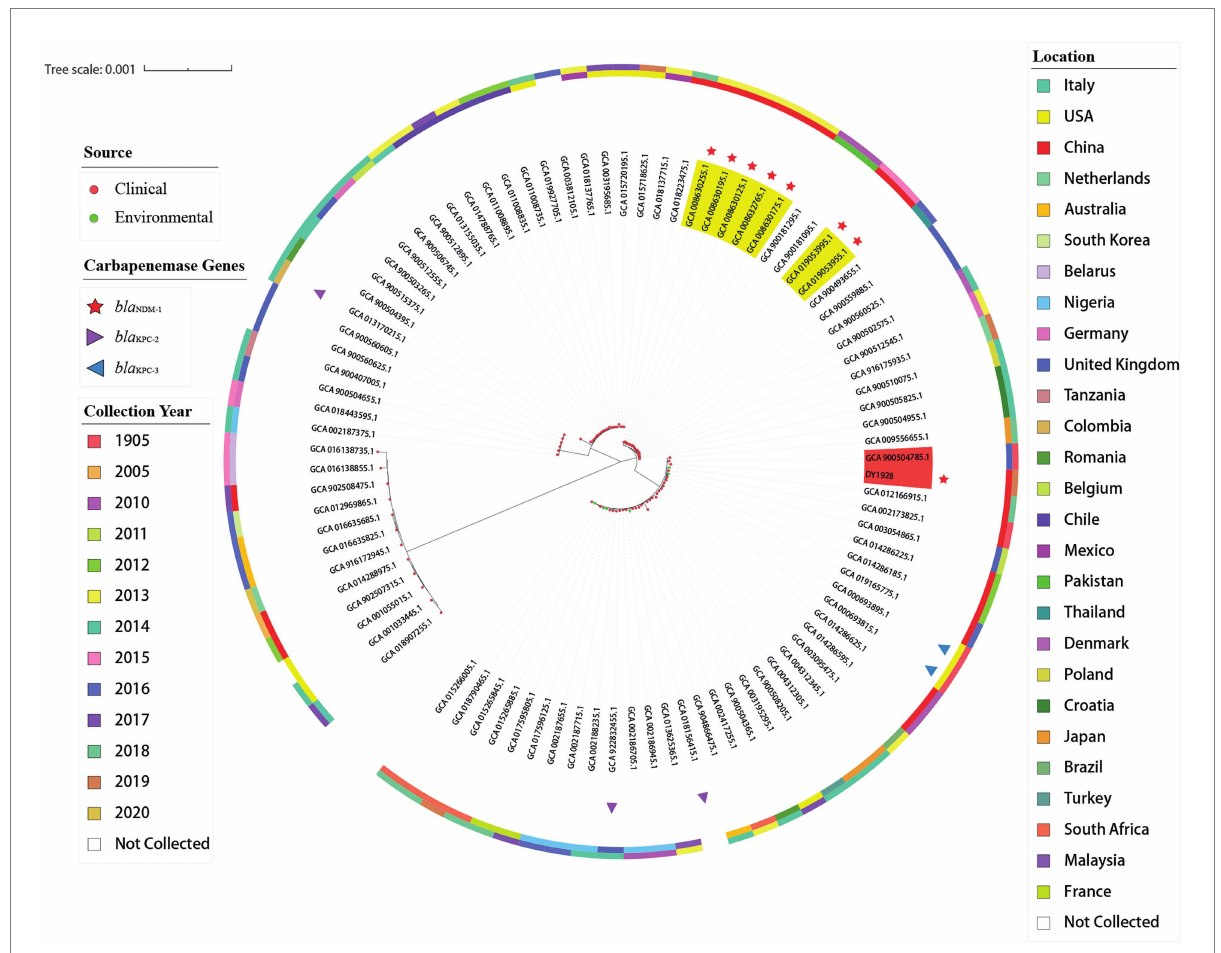
FIGURE 3 Phylogenetic trees of 91 K. pneumoniae strains of ST25. In the figure, the middle part is the maximum likelihood core-gene phylogeny generated by MEGA11. The sources, carbapenemase genes carried, locations, and collection years of all ST25 K. pneumoniae strains included here are indicated in the